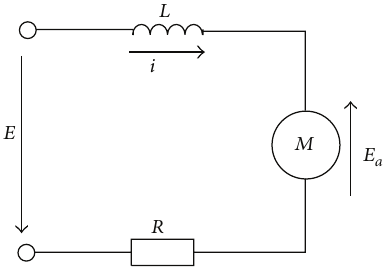
Figure 3: Equivalent circuit model of linear motor.